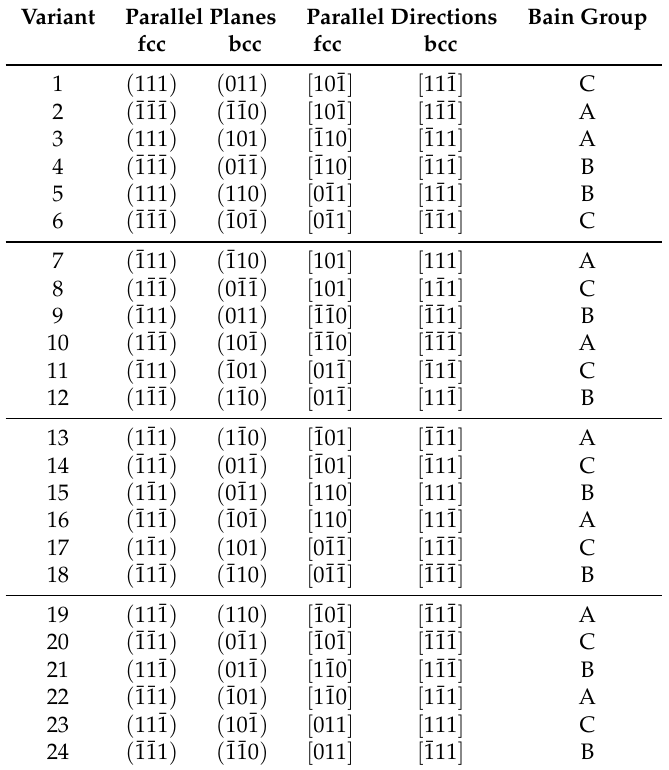
Table A2. The combination of parallel plane normals and parallel in-plane directions in between face centered cubic (FCC) and body centered cubic (BCC) lattices corresponding to the theoretical obtained Kurdjumov–Sachs (KS) orientation